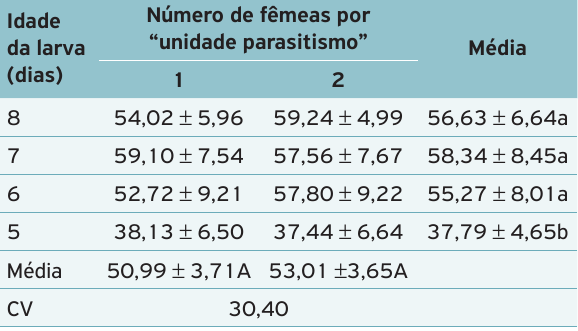
Tabela 2. Médias ( ± Erro Padrão) do Índice de Parasitismo (%) de Diachasmimorpha longicaudata sobre larvas de Ceratitis capitata de diferentes idades. Temperatura 26 ± 1ºC; UR 65 ± 10%